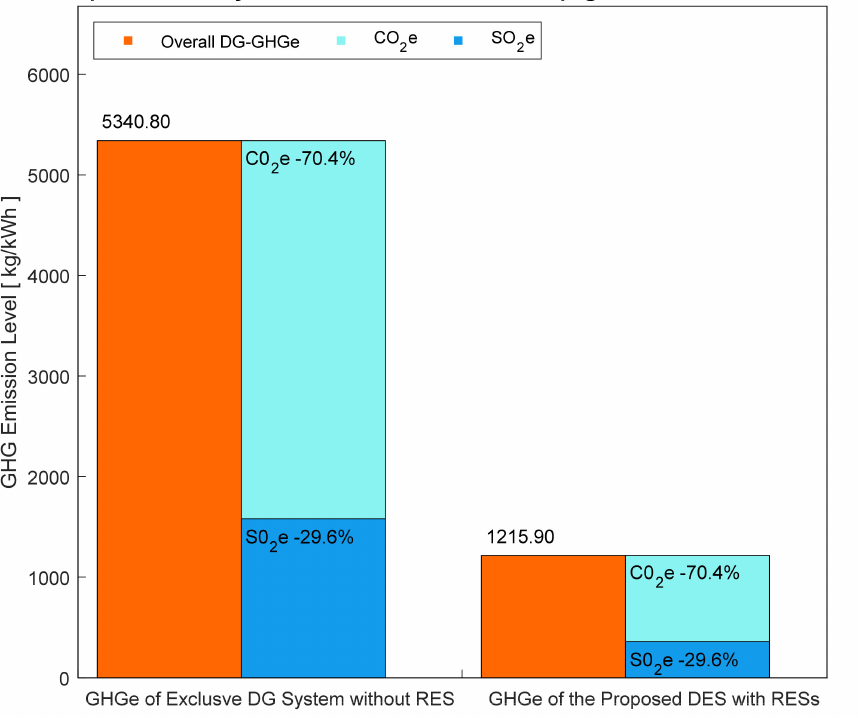
Figure 16. Comparison of greenhouse gas emission for the exclusive DG system and DES